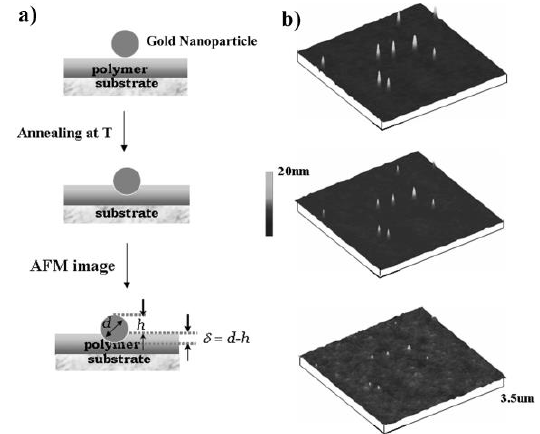
Figure 3. ( a ) Schematics of nanoparticle embedding technique. ( b ) AFM images of nanoparticle on 120 nm PS film annealed at 90 ◦ C ( Top ), 100 ◦ C ( Middle ) and 110 ◦ C ( Bottom ) in vacuum.